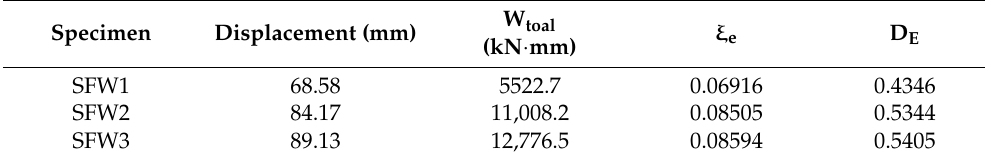
Table 6. Energy dissipation parameters of specimens at ultimate state.